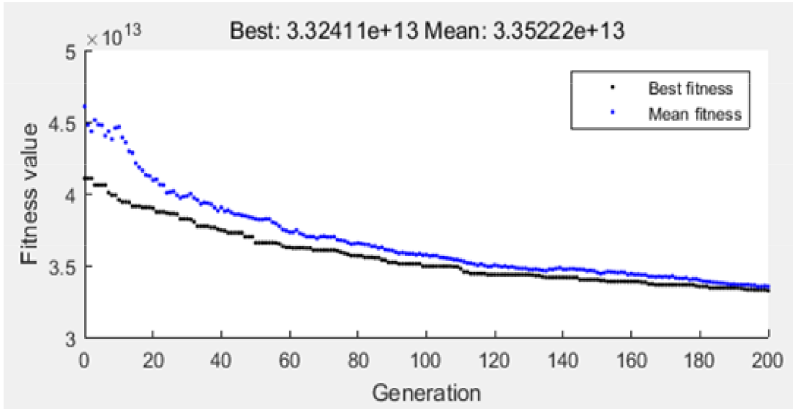
Figure 2. Convergence curve of genetic